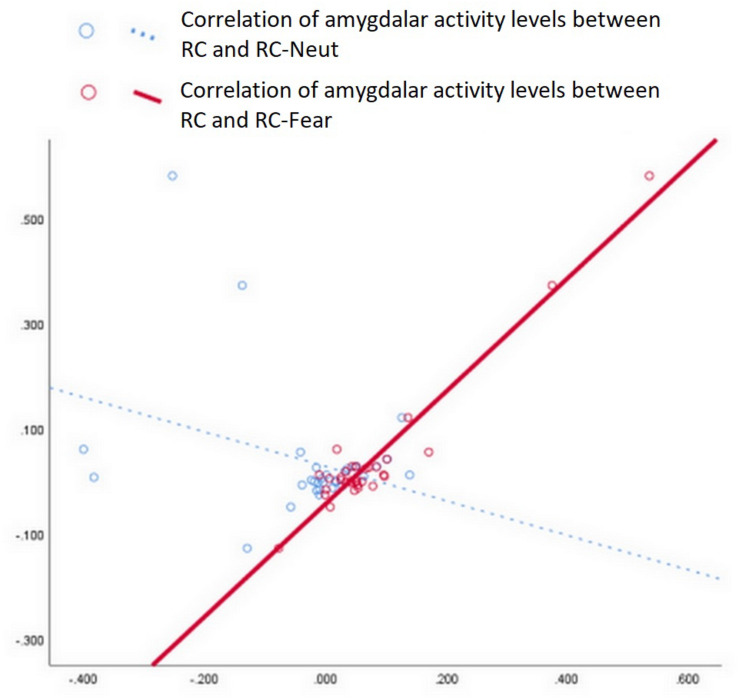
Correlation analysis of amygdala values between RC and RC-Fear, as well as between RC and RC-Neut. A strong positive correlation was only significant between RC and RC-Fear (p < 0.001, Bonferroni uncorrected).